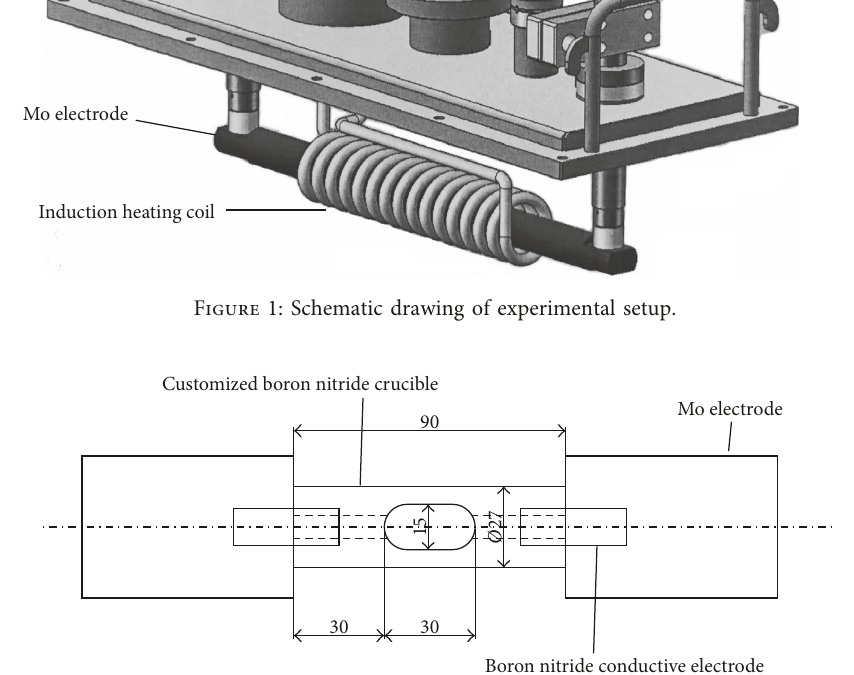
Figure 2: Schematic sketch of the crucible and the